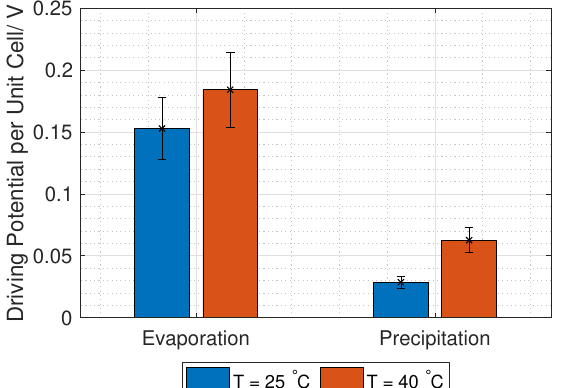
Figure 15. Driving force for RED using concentrations relevant for the separation techniques evaporation and precipitation.